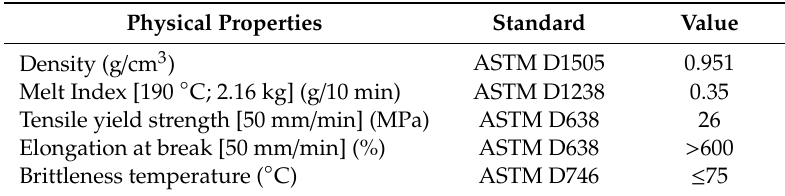
Table 1. Nominal physical properties of high-density polyethylene (HDPE) HHM 5202 BN.